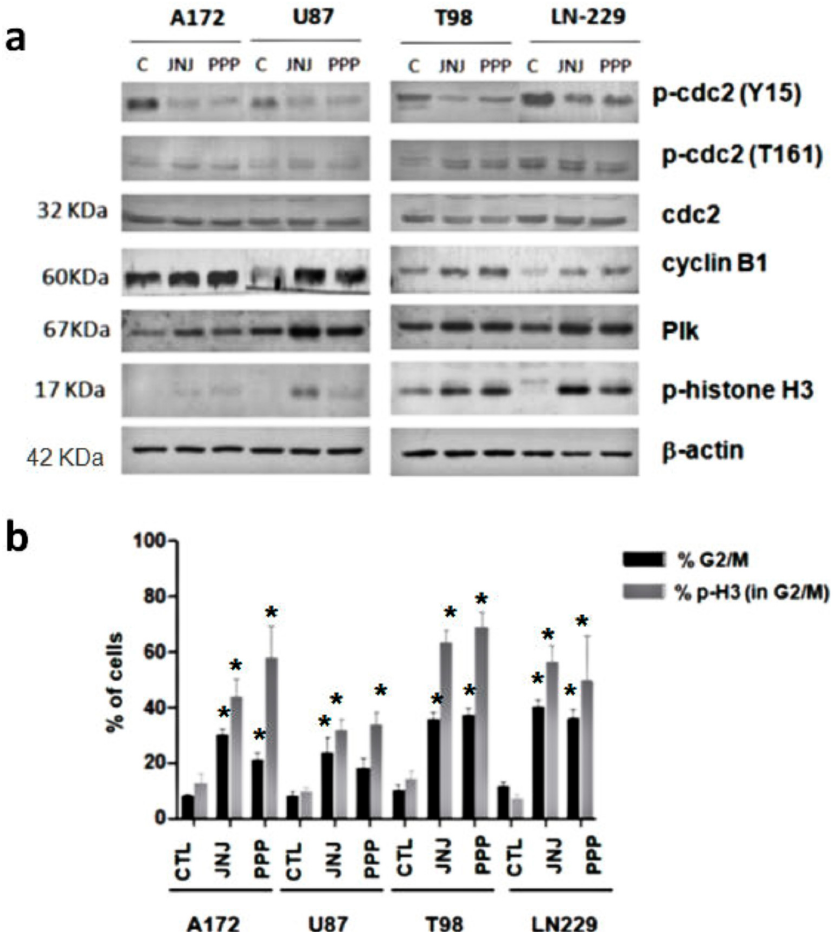
Figure 4. Study of the G 2 /M arrest. ( a ) JNJ and PPP effects on G 2 /M checkpoint proteins. LN-229 cells were treated with DMSO (C), 500 nm JNJ or 500 nm PPP for 16 h and subjected to Western blot analysis using the antibodies indicated. (cid:108) -actin was used as a loading control. ( b ) Induction of mitotic arrest. GBM cell lines were seeded, treated with DMSO (CTL), 500 nm JNJ or 500 PPP for 16 h and stained with phospho-histone H3 antibody and propidium iodide, as described in Materials and Methods. The percentage of cells in the G 2 /M phase (black bars) and the percentage of p-histone H3 positive cells within the G 2 /M phase (grey bars) are represented as the average of four independent experiments. Error bars are the S.E.M. * Mean a statistically significative change, as compared to control untreated cells, p < 0.05.